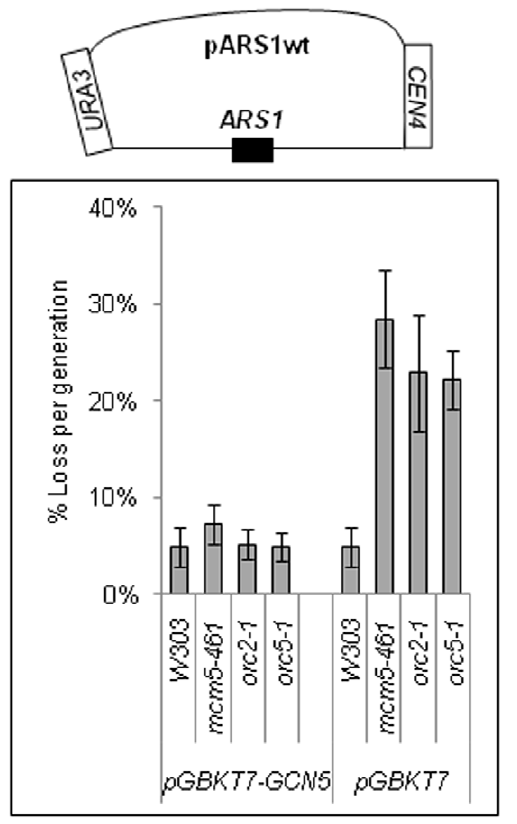
Figure 2. High copy number of GCN5 suppresses mini- chromosome instability in mcm5-461,orc2-1andorc5-1 . W303 , mcm5-461, orc2-1 and orc5-1 cells carrying pARS1wt ( ARS1, CEN4, URA3 ) were transformed with pGBKT7 ( 2 m m/TRP1 ) or pGBKT7- GCN5 . After selection on SC-trp-ura plates three colonies were transferred for 20 generations in SC-trp and then plated on SC-trp and SC-trp-ura, respectively. The proportion of cells with URA + phenotype was estimated and the average loss per generation of pARS1wt was calculated (%) as in Fig. 1A and plotted. A typical outcome of one of two independent experiments is shown.